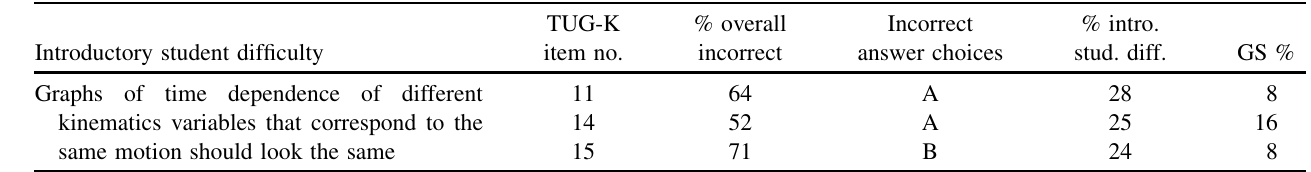
EXPLORING ONE ASPECT OF PEDAGOGICAL . . TABLE III. Introductory student difficulty that graphs of time dependence of different kinematics variables that correspond to the same motion should look the same, items on the TUG-K which uncover this difficulty (TUG-K item no.), percentage of introductory students who answer the items incorrectly (% overall incorrect), incorrect answer choices which uncover this difficulty, percentage of introductory students who have this difficulty based on their selection of these answer choices (% intro. stud. diff.), and percentage of graduate students who select these answer choices as the most common incorrect answer choices of introductory students (GS %). For convenience, short descriptions of the questions are given underneath.